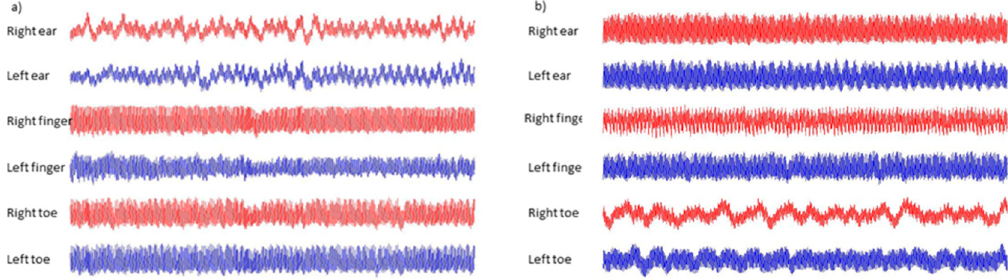
Figure 2. An example of the original multi-site PPG recordings over a period of five minutes for ( a ) a healthy control and ( b ) a peripheral arterial disease (PAD) patient. Note: The amplitude levels for each body site in ( a ) and ( b ) are scaled to fit the plot and do not represent the gain normalized levels.